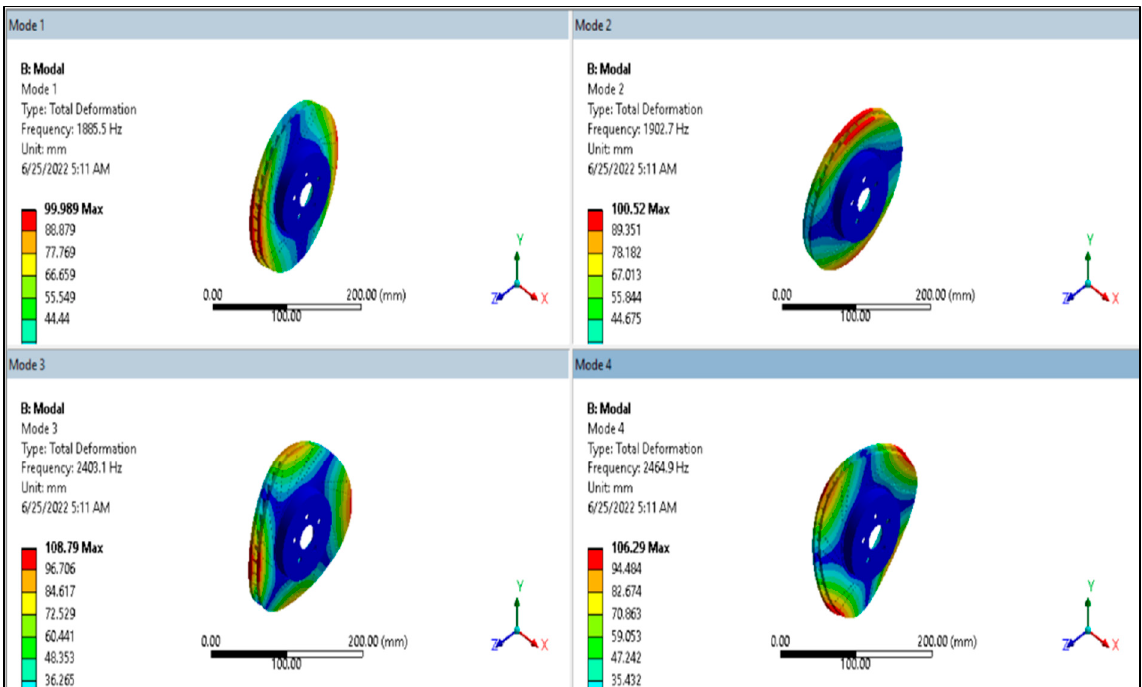
Figure 6. Mode shape result of aluminum alloy disc.